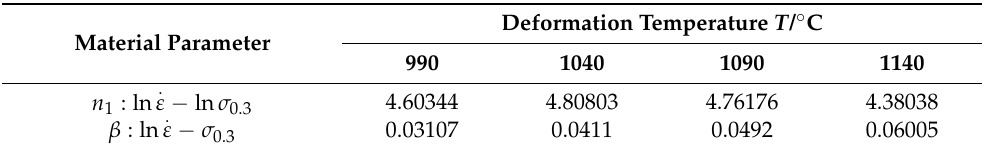
. ε under different temperatures.